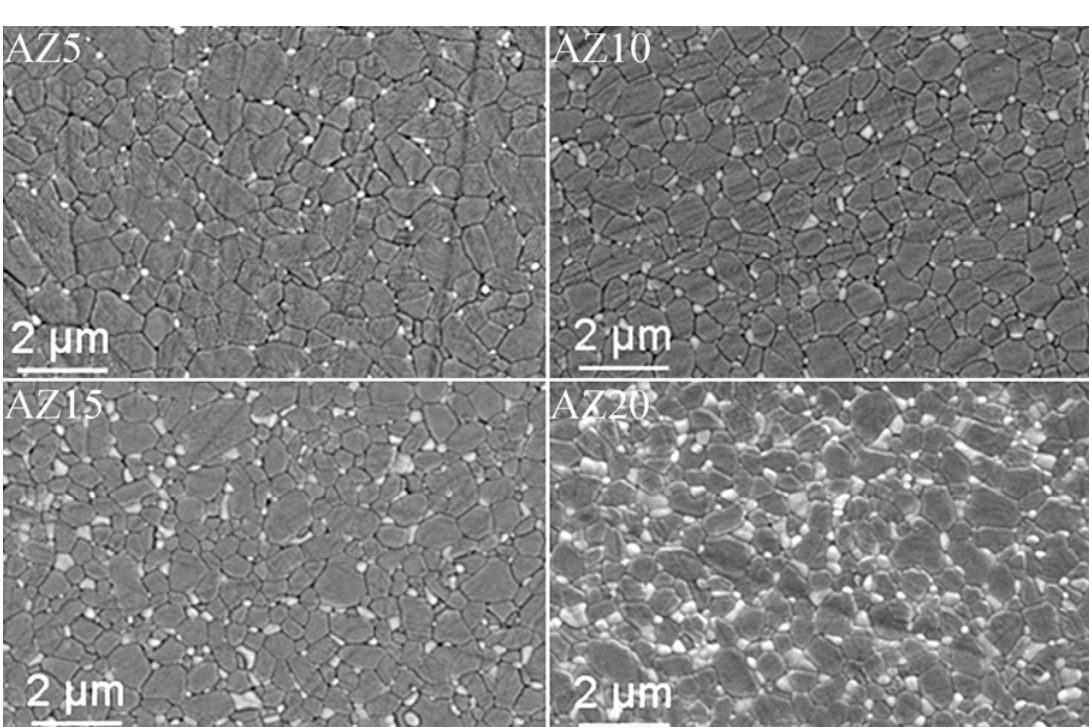
Figure 4. Environmental scanning electron microscopy (ESEM) images of sintered materials obtained by slip casting (observations on polished and thermally etched surfaces).